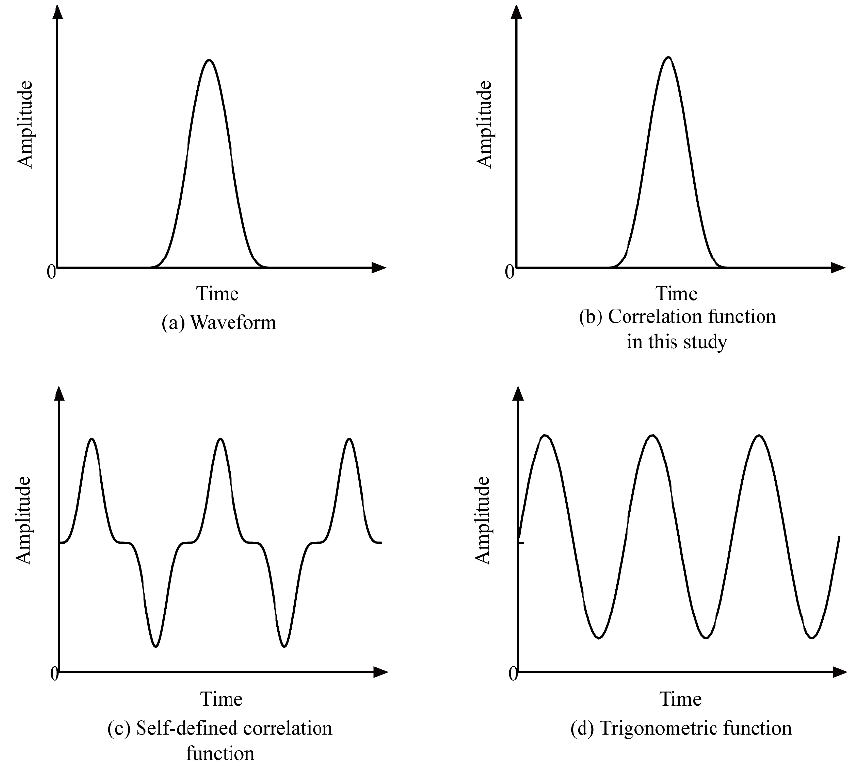
Figure 1. Comparison of correlation functions: ( a ) Simulated waveform; ( b ) raw waveform as correlation function in this study; ( c ) self-defined correlation function proposed by Kong, et al. [26]; ( d ) trigonometric function for FT.